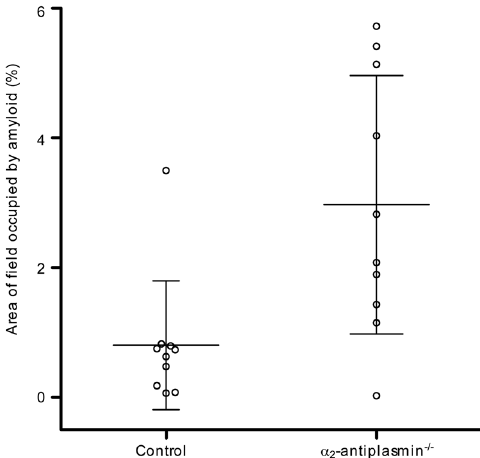
Fig. 7 Effect of α 2 -antiplasmin de fi ciency on amyloid deposition. Amyloid deposition was enhanced by α 2 -antiplasmin de fi ciency ( P = 0.0068, Mann – Whitney test, two-tailed). Estimates of lingual amyloid content (individual values, mean and SD) are shown for male line N4 human TTR S52P mice that were wild-type (control) or homozygous for an α antiplasmin knockout allele ( n = 10 each group). The tissues were collected 2 months after amyloid deposition was seeded by injection of human TTR S52P amyloidotic spleen homogenate. Similar results were obtained when comparing α 2 -antiplasmin de fi cient (homozygous knockout) with control heterozygous α 2 -antiplasmin knockout male mice ( P = 0.0047, Mann – Whitney test, two-tailed, n = 7 controls, 6 knockouts). Source data are provided as a Source Data fi